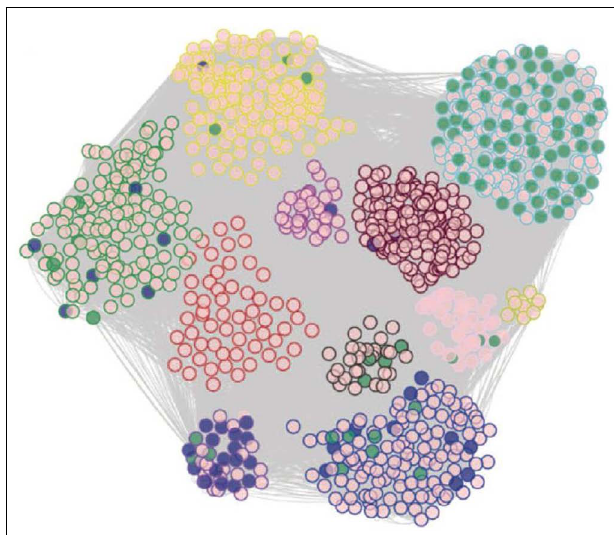
FIGURE 10 | Modeling of biologic networks using co-expression analysis . In this study, cultured endothelial cells from roughly 147 human subjects were analyzed using expression arrays before and after treatment of oxidized phospholipids. A set of about 2,000 genes that were regulated by the oxidized phospholipids were selected and analyzed using co-expression network analysis using theWGCNA algorithm, developed by Horvath and colleagues (labs.genetics.ucla.edu/horvath/ CoexpressionNetwork). A total of 11 modules of tightly correlated genes were observed in the network and most of these were highly enriched for certain Gene Ontology pathways. [Figure from Romanoski et al. (2010) and Romanoski et al. (2011) with